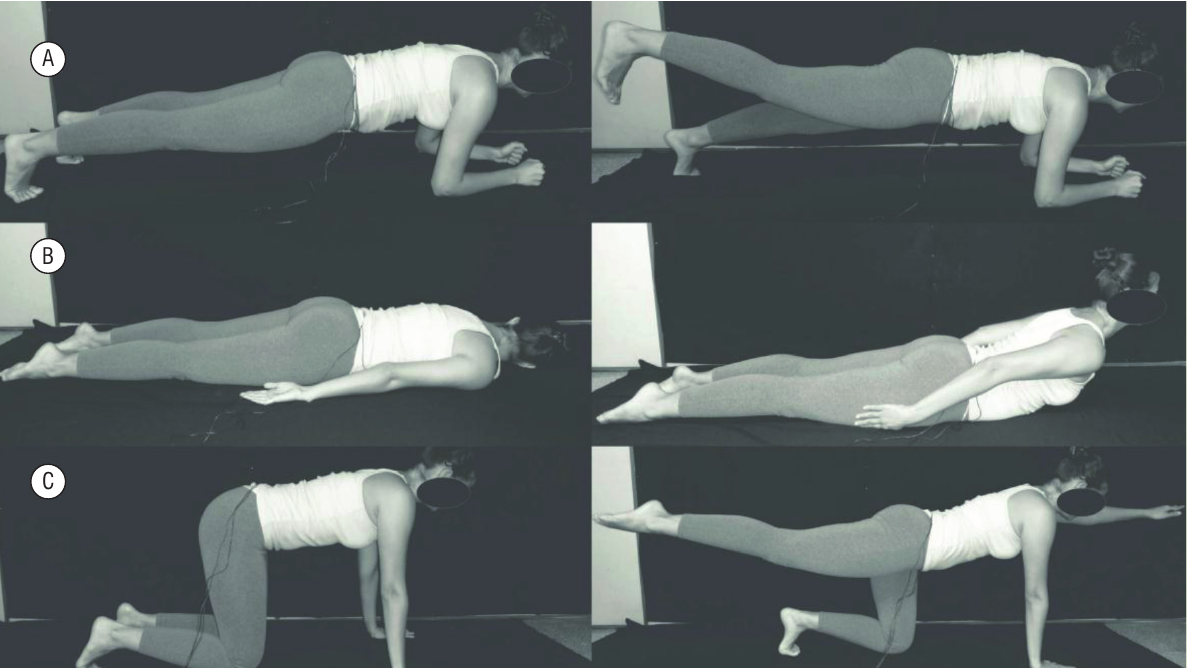
Figura 1 - Exercícios analisados: Leg pull front support, do método Pilates (A); quarto exercício da série adicional, da Série de Williams (B); e Quadruped exercise, do Spine